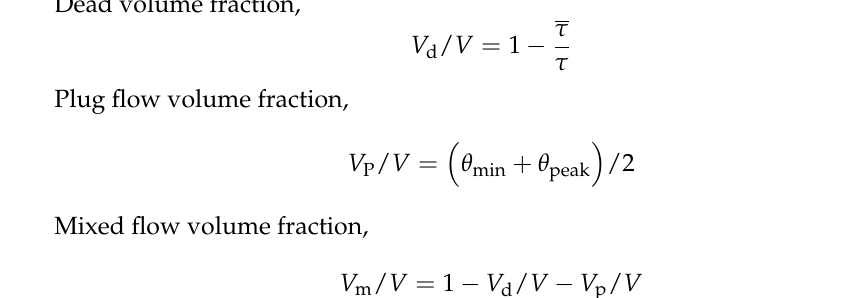
Figure 2. Theoretical models of tundish: ( a ) single-tank model; ( b ) tanks-in-series model; ( c ) schematic illustration. Dead volume fraction,